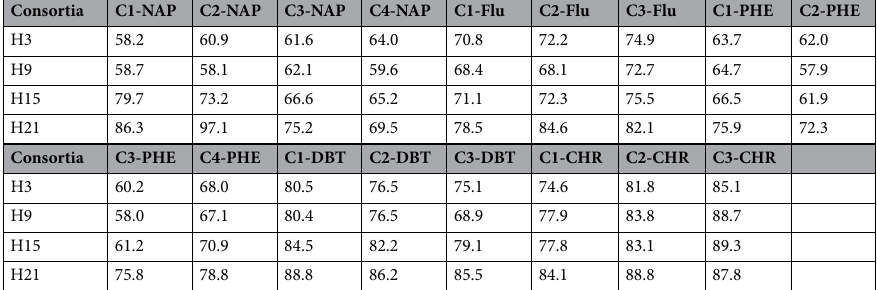
Table 6. The alkylated PAHs degradation efficiency in the crude oil after biodegrading 3, 9, 15 and 21 days by consortium H. NAP, FLU, DBT, PHE, and CHR represent for naphthalene, fluorine, dibenzothiophene, phenanthrene, chrysene, respectively. C1(C2, C3, C4)-NAP, alkylated naphthalene with straight-chain of 1 ~ 4 carbon atoms; C1(C2, C3)-FLU, alkylated fluorene with straight-chain of 1 ~ 3 carbon atoms; C1(C2, C3)-DBT, alkylated dibenantherene with straight-chain of 1 ~ 3 carbon atoms; C1(C2, C3, C4)-PHE, alkylated phenanthrene with straight-chain of 1 ~ 4 carbon atoms; C1(C2)-CHR, alkylated chrysene with straight-chain of 1 ~ 2 carbon